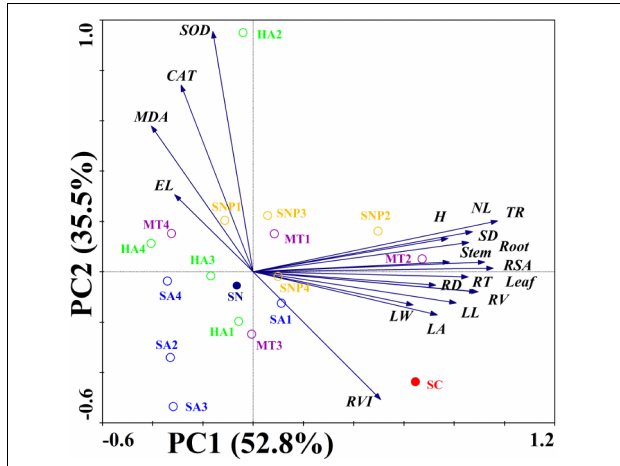
FIGURE 6 | Principal component analysis and factor scores for the selected related growth indicators as the first two principal components. Root, root weight; Stem, stem weight; Leaf, leaf weight; H, plant height; SD, Stem diameter; NL, number of leaves; LL, leaf length; LW, leaf width; LA, leaf area; TRL, total root length; RSA, root surface area; RD, root diameter; RV, root volume; RT, root tips; RVI, root vitality; EL, electrolytic leakage; MDA, MDA content; SOD, SOD enzyme activity; CAT, CAT enzyme